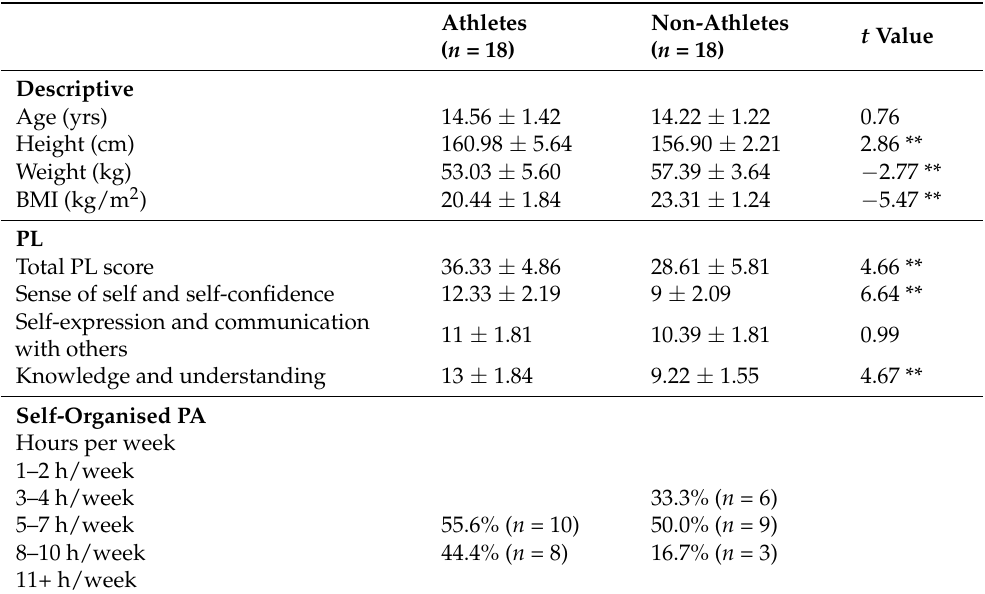
Table 1. Descriptive characteristics, PL, and self-organised PA in athletes and non-athletes (mean ±